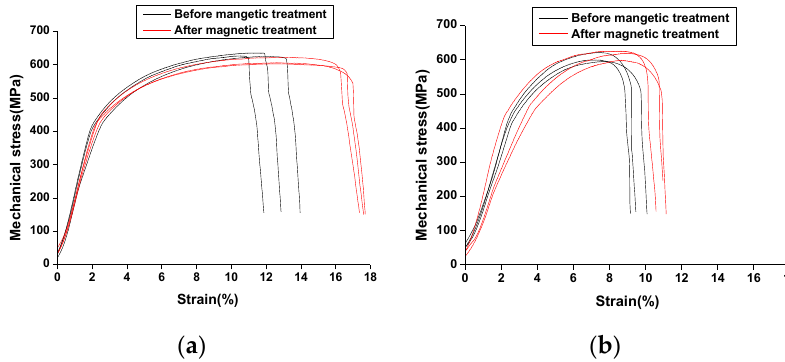
Figure 4. Engineering stress–engineering strain curves before and after magnetic treatments: ( a ) large size; and ( b ) small size.